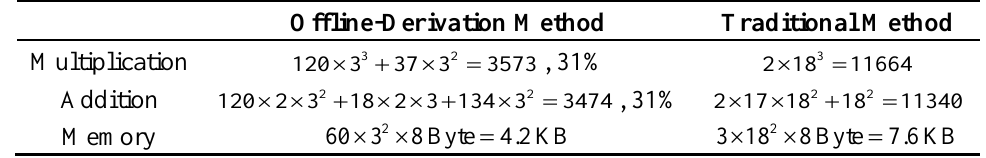
Table 4. Optimization efficiency